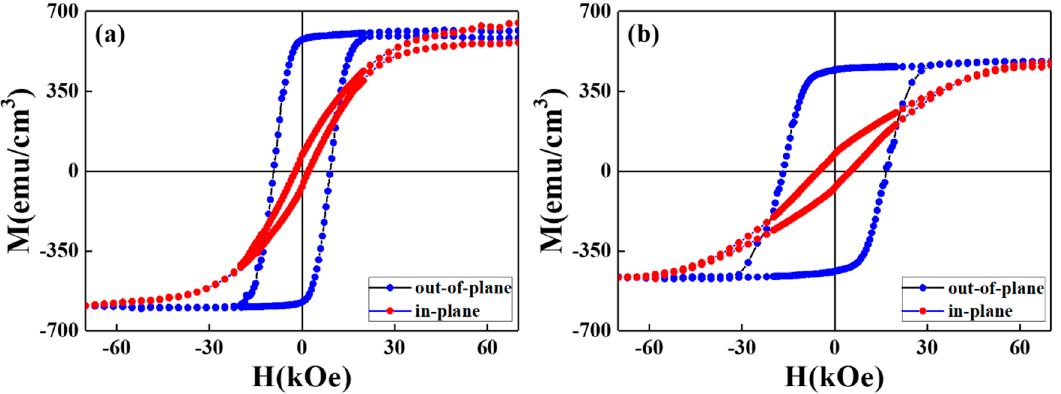
Figure 2. Easy-(out-of-plane) and hard-(in-plane) axis magnetization loops of ( a ) reference sample and ( b ) FePtCAg/MgTiOBN films measured at 350 K.